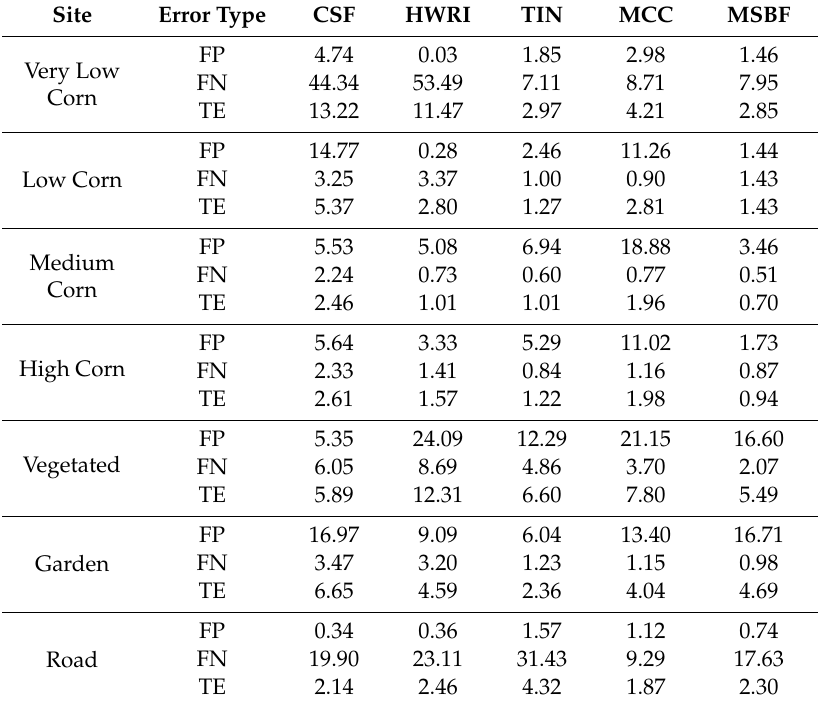
Table 4. The % false positive (FP), % false negative (FN), and % total error for all